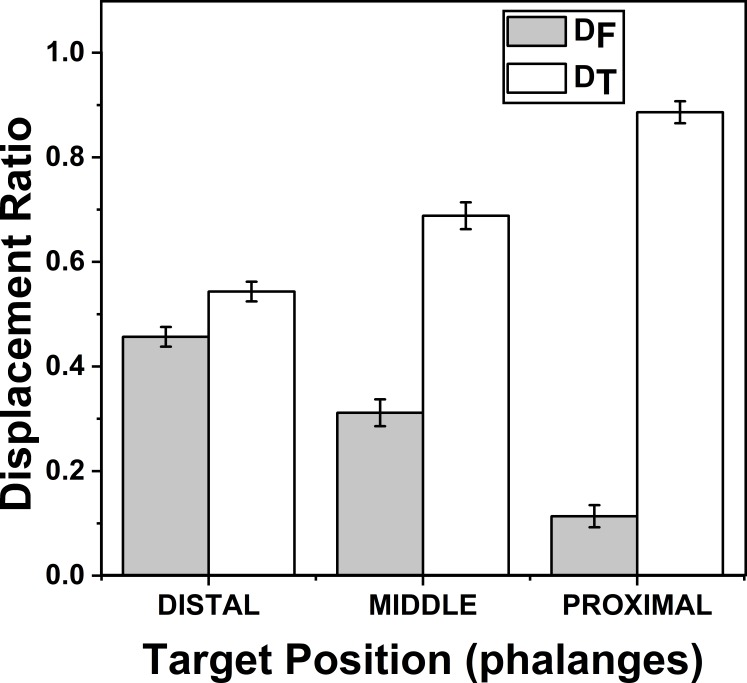
Change of Displacement Ratio for different target Phalanges positions.DF reduces significantly (p < 0.001) when the target Phalanx was changed from distal to proximal phalanx while DT increases significantly (p < 0.001) when the target phalanx was changed in the same order. A higher value of D indicates a greater contribution. The columns and bars indicate means and standard error of means.